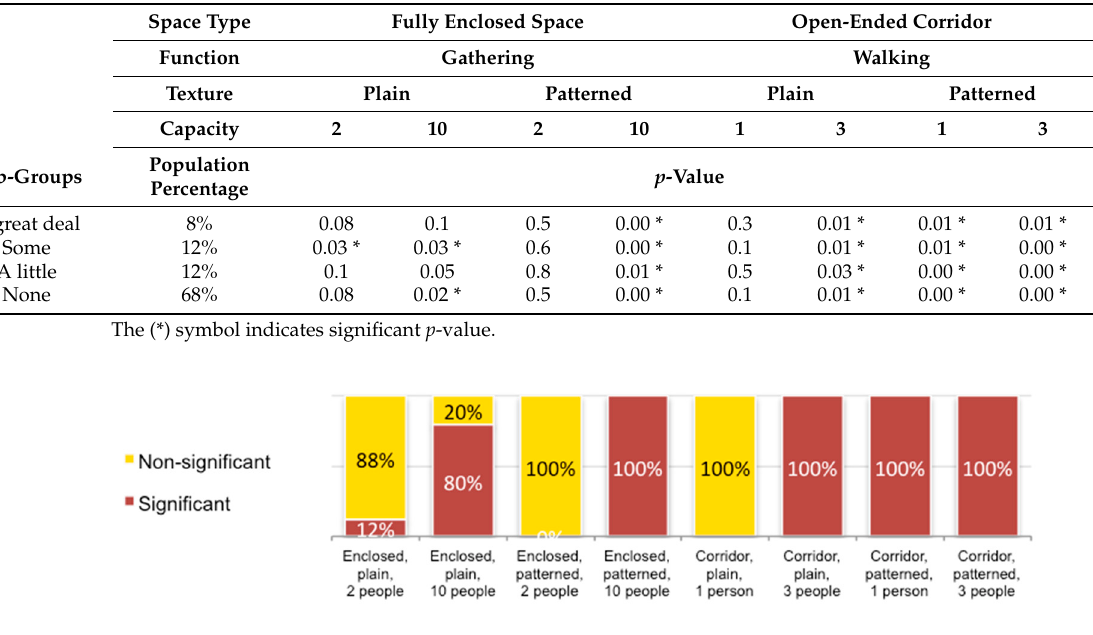
Table 10. Direct design experience with the IVRIE perception filter and comparisons of space size variations between IVRIE and DT systems.